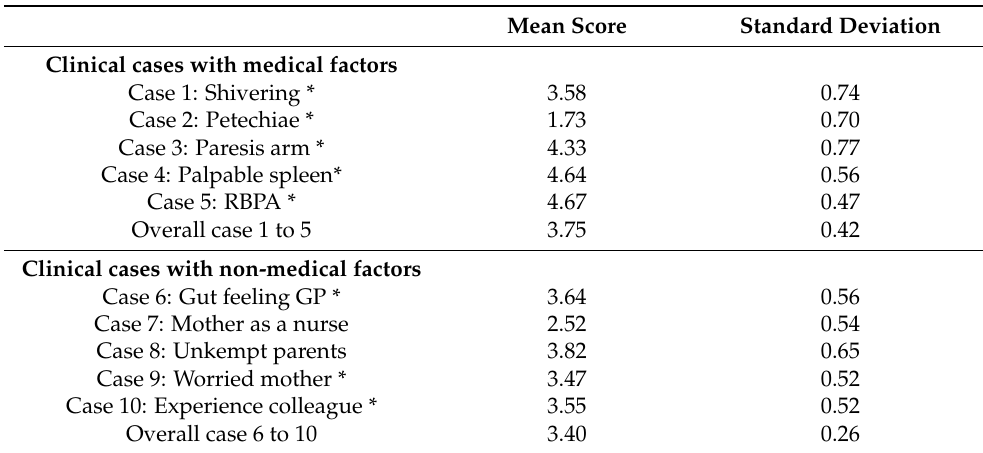
Table A1. Mean scores and standard deviations of individual